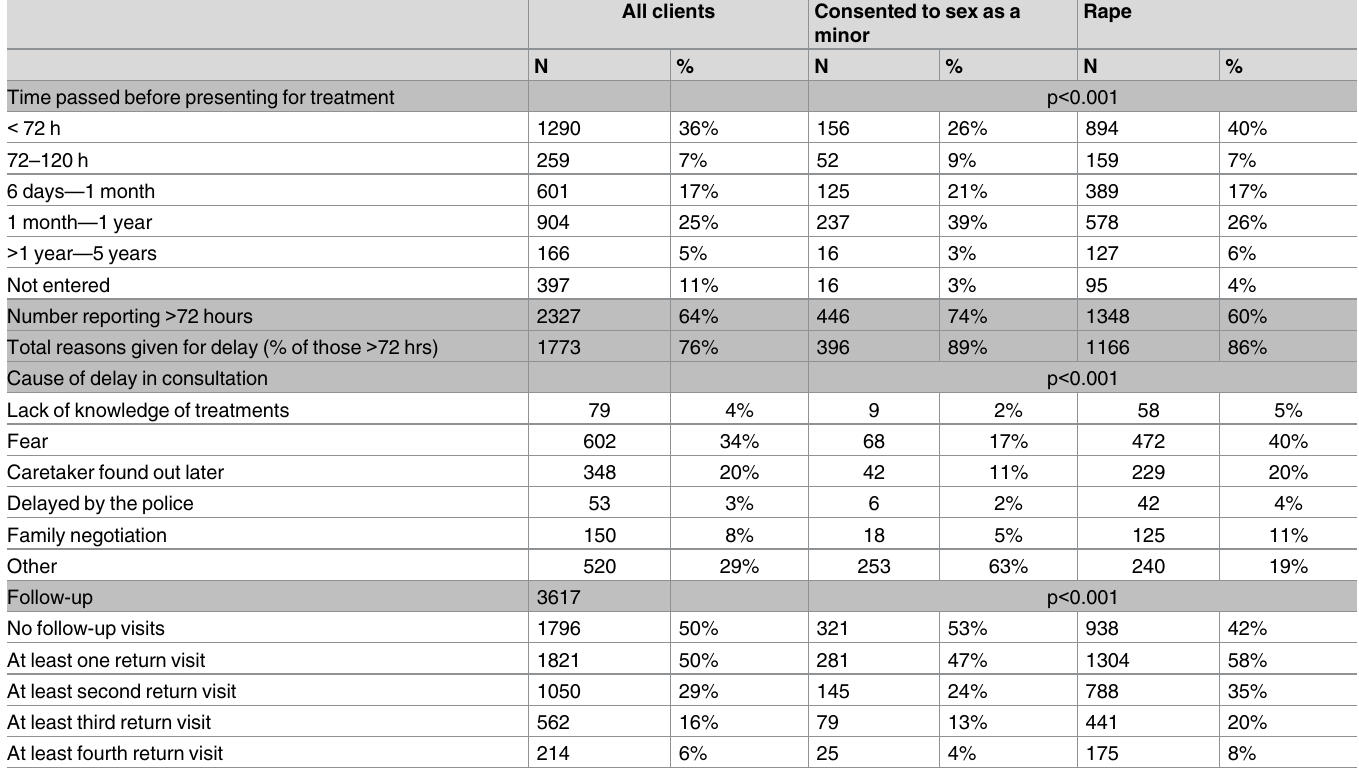
Table 2. Time to presentation and follow-up, Mbare SGBV clinic (09/11–12/2014).